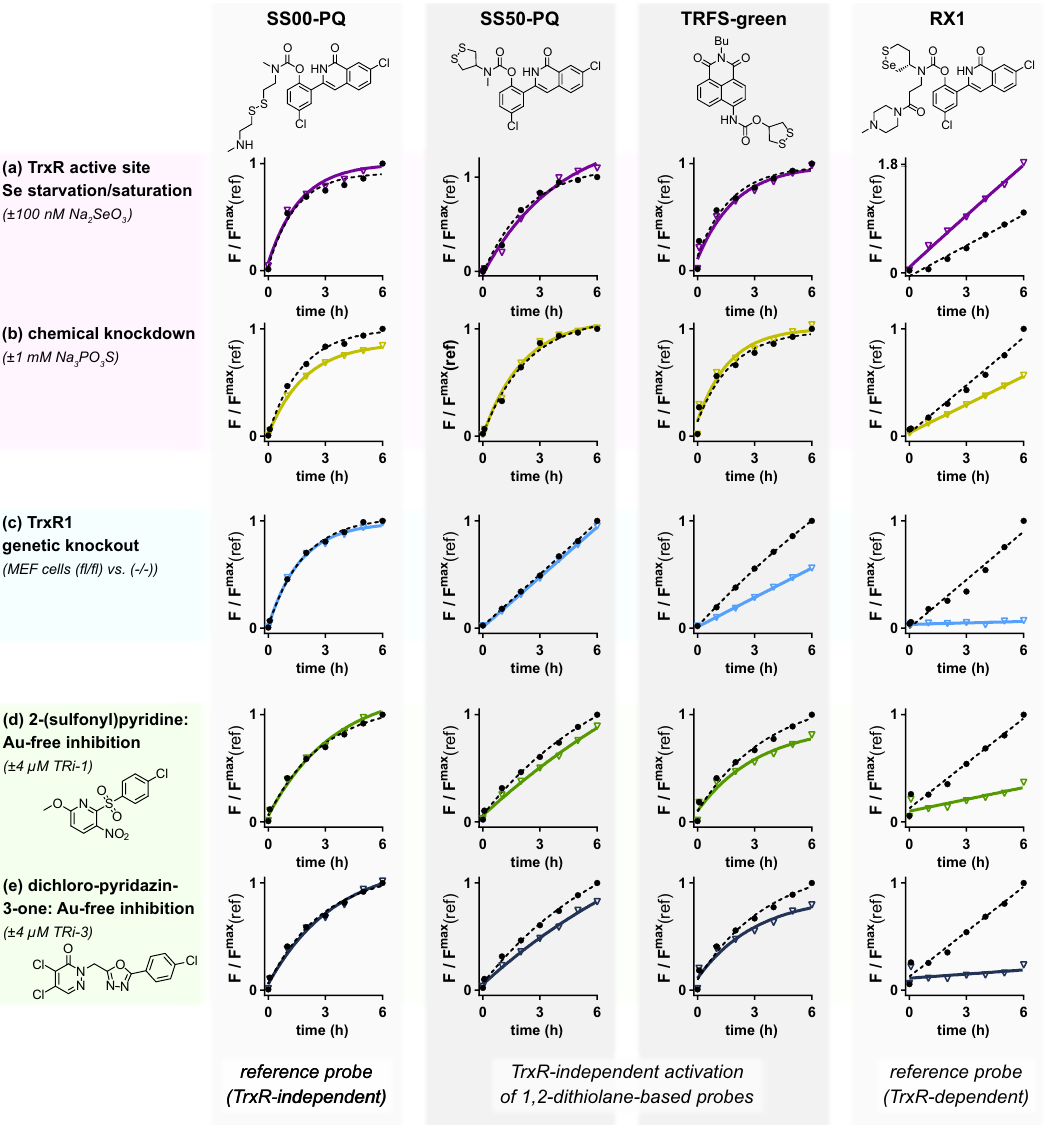
Fig. 5 Cellular signal from 1,2-dithiolane probes does not report on TrxR. a – e Cellular fl uorescence timecourse studies of SS50-PQ and TRFS-green , with the TrxR-independent SS00-PQ and the TrxR-dependent RX1 as benchmarks for assay outcomes. a A549 cells starved of, or supplemented with, selenium (as Na 2 SeO 3 ) (probes at 100 µ M; full data in Supplementary Fig. 8a). A549 cells treated with Na 3 PO 3 S (probes at 100 µ M; full data in Supplementary Fig. 8b). c TrxR1-knockout ( − / − ) and -wildtype ( fl / fl ) MEF cells (probes at 100 µ M; full data in Supplementary Fig. 8c). d , e A549 cells pre-incubated for 2 h with the gold-free TrxR inhibitors TRi-1 and TRi-3 (probes at 50 µ M; full data in Supplementary Fig. 10 – 13). ( a – e : data shown as mean from 3 independent experiments; full representations in Supplementary Information). Note: plots on the same graphs are run under identical conditions except for the indicated variable (TrxR knockout/presence, etc.) so are kinetically